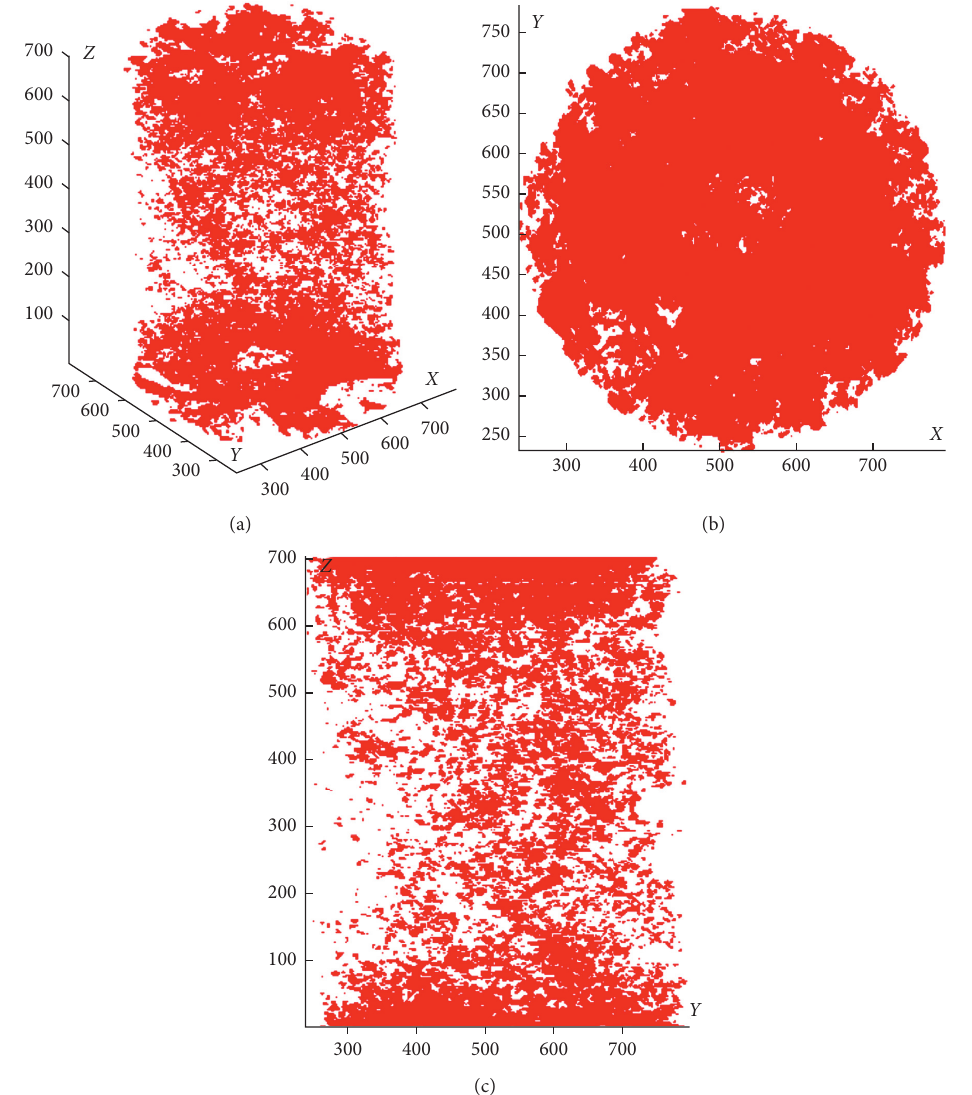
Figure 12: Air void distribution of AC13 specimen. (a) Three dimensions. (b) Projection in transverse section. (c) Projection in vertical